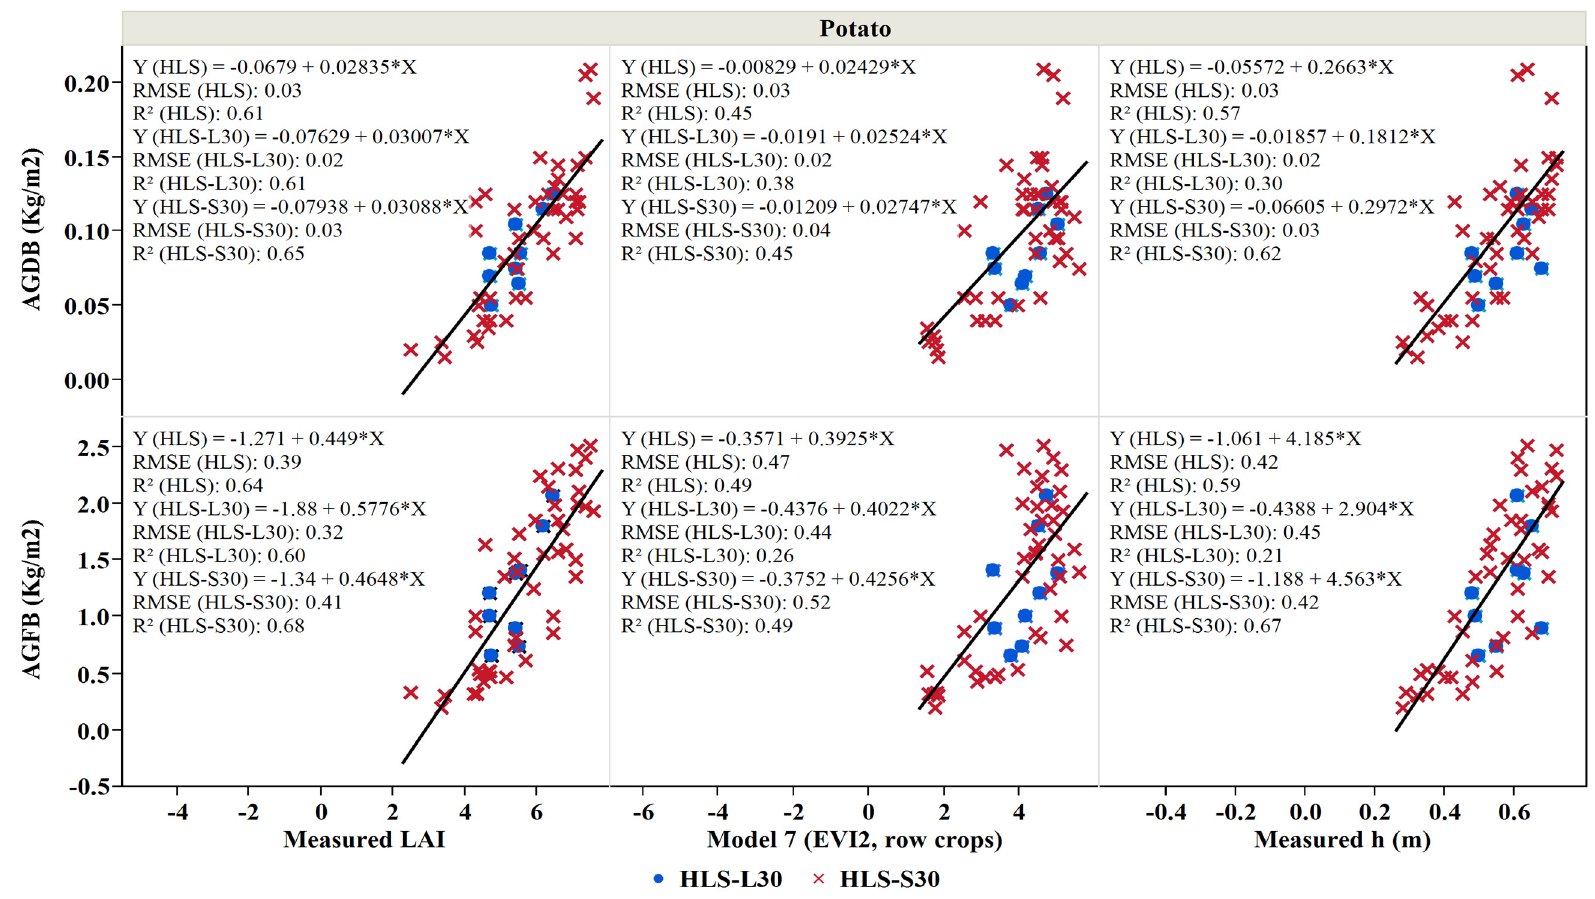
Figure 13. Above-ground fresh (AGFB) and dry (AGDB) biomass weight as a function of LAI derived from Model 7 (EVI2, row crops), measured LAI, and height (h) for potato fields combined during the 2019 growing season. Blue points represent the measurements during Landsat overpass and the red crosses represent the measurements during Sentinel 2 overpass.